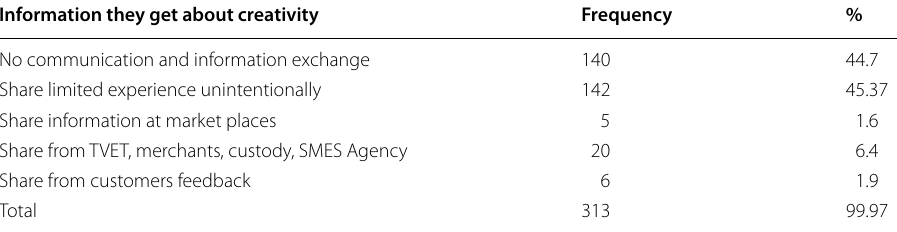
Table 3 Types of communication employed to exchange information on creativity Information they get about creativity No communication and information